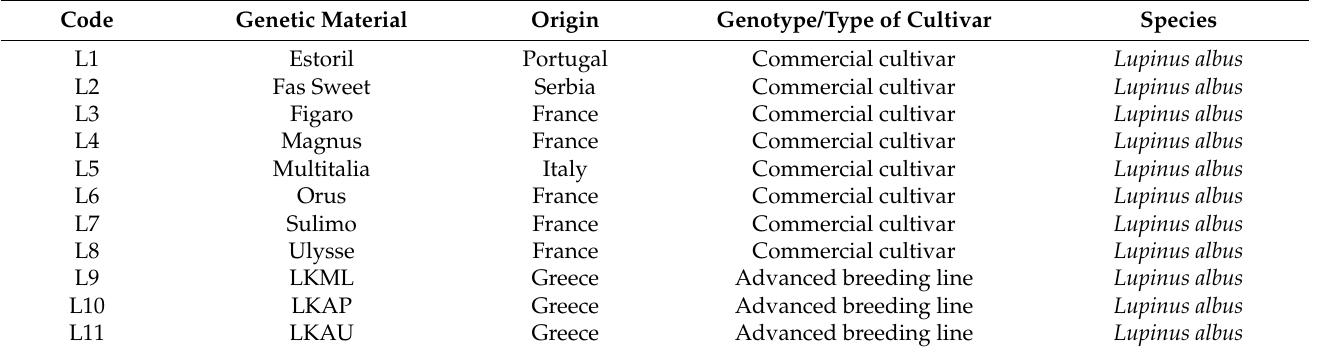
Table 1. Lupin cultivars used in this research.